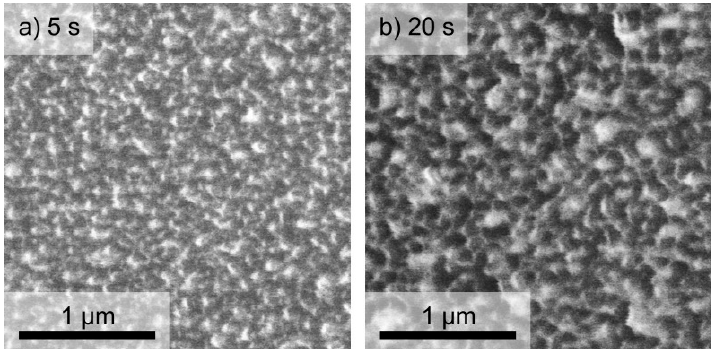
Figure 4. SEM micrographs of DLC:Ag (Sample 2) after different durations of O 2 processing: ( a ) 5 s; ( b ) 20 s. Scale bar: 1 µm.